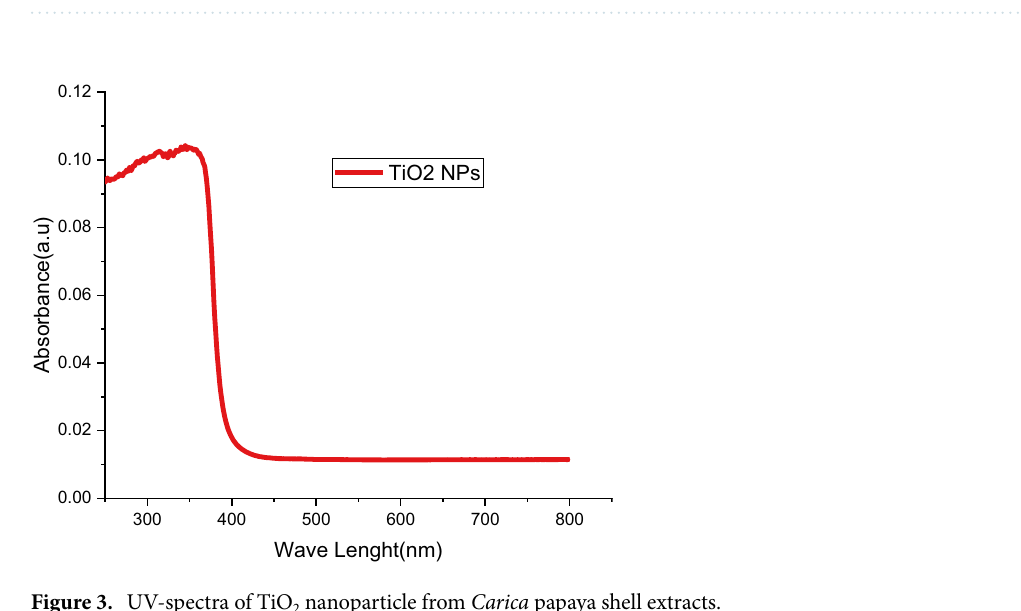
Figure 2. Graphic observations of TiO 2 nanoparticle preparation ( a ) Titanium Iso-propoxide solution, ( b ) caricca papaya Shell extracts, ( c ) changed color.